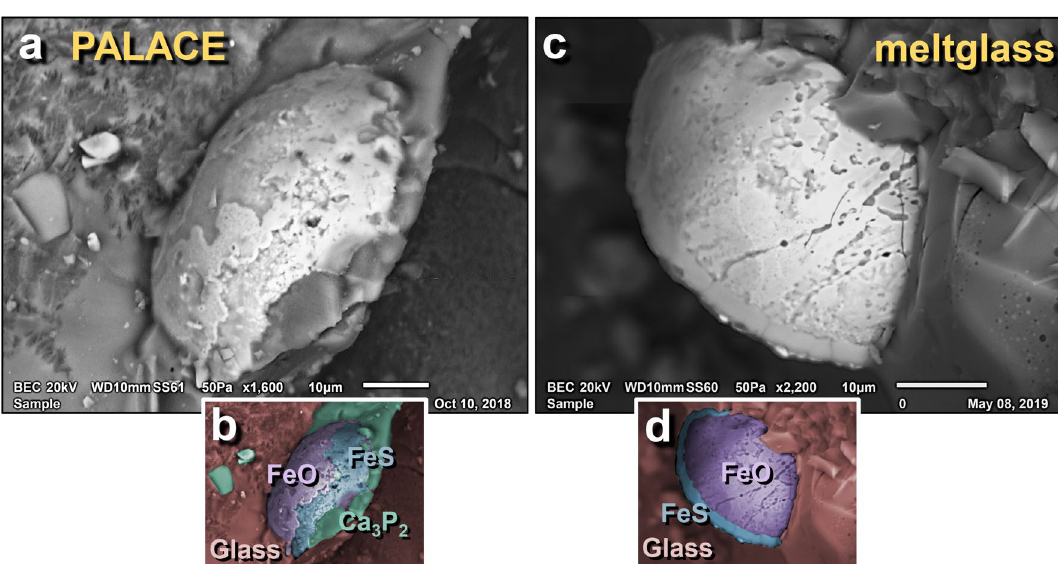
Figure 41. SEM images of Fe–S–Ca–P-rich grains in mudbrick meltglass from the palace. ( a ) Melted Fe-rich grain is chemically complex, containing Fe, S, Ca, and P. ( b ) Manually constructed EDS-based phase map marking areas of Fe oxides (purple, labeled as FeO), FeS (blue), and Ca 3 P 2 , calcium phosphide (green). ( c ) High- temperature melted Fe-rich grain; ( d ) manually constructed EDS-based phase map showing the area that is predominantly Fe oxide, bordered by a thin rim of